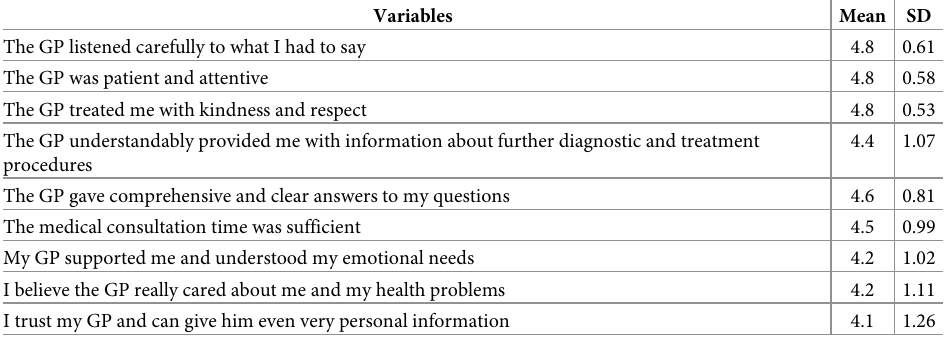
Table 5. Variables used to measure the quality of communication with GP.